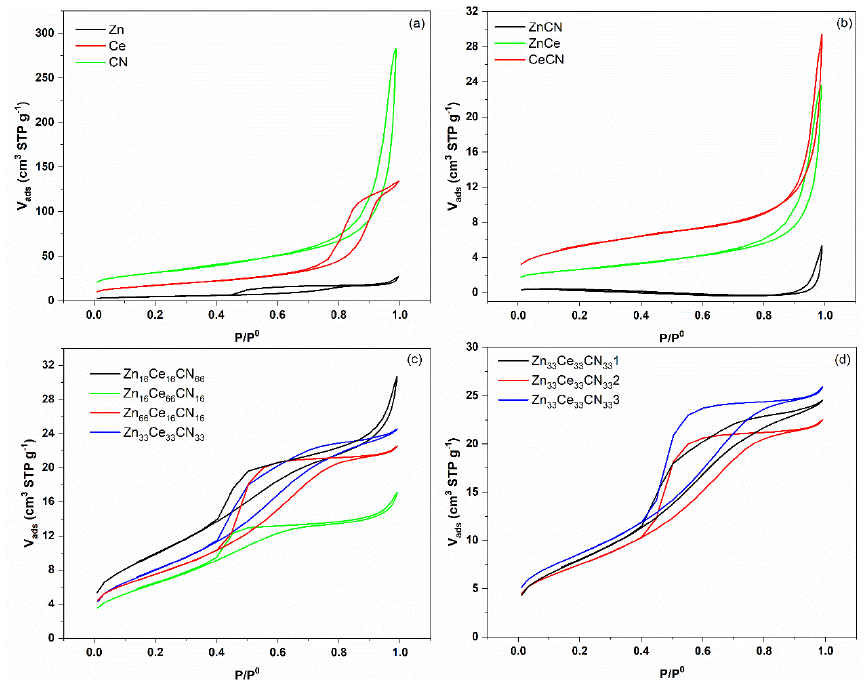
Figure 2. Nitrogen adsorption/desorption processes of pure ( a ), binary ( b ), ternary ( c ), and replica samples ( d ).